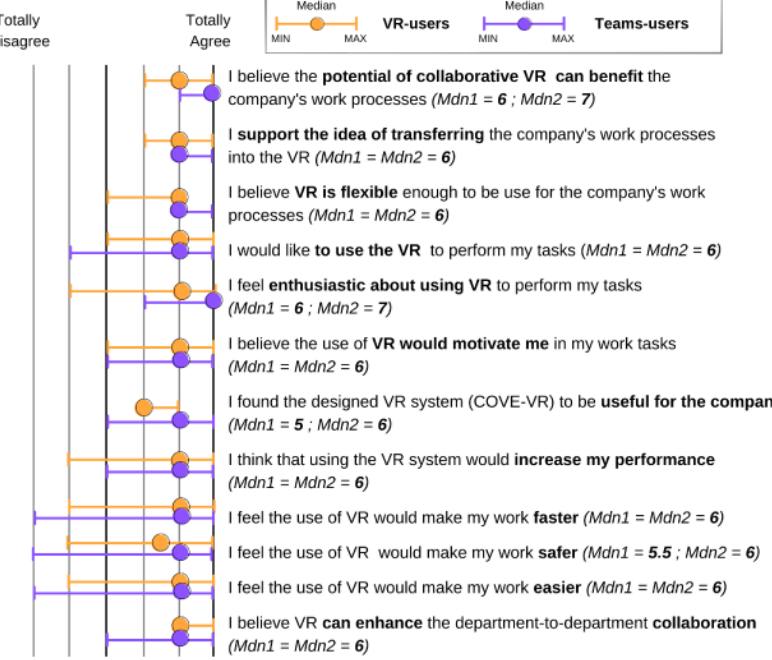
Figure 7. Employees’ perceptions of VR technology for the industrial context.